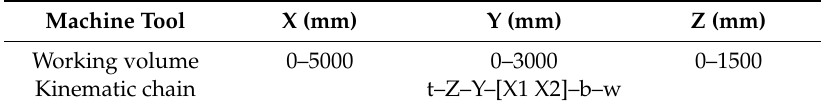
Table 2. Virtual machine specifications. Kinematic chain represented according to ISO 841 and ISO 10791-6 [22,23] (t: tool; b: bed; w: workpiece).